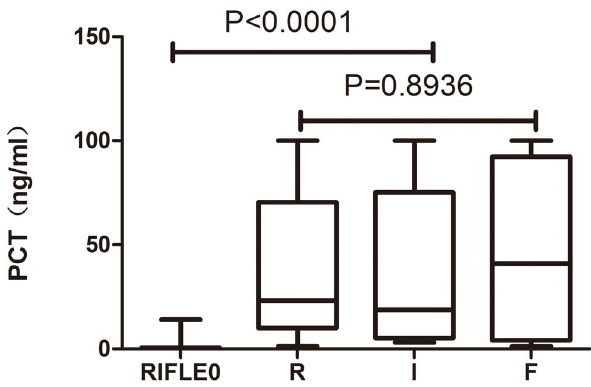
Figure 4. PCT levels in patients stratified by RIFLE classes. RIFLE=Risk, Injury, Failure, Loss, and End-stage kidney disease. PCT levels were compared between AKI (RIFLE classes Risk, Injury, and Failure) and non-AKI (RIFLE 0) patients using the Wilcoxon rank sum test, and PCT levels were compared among the RIFLE classes Risk, Injury, and Failure using the Kruskal-Wallis H test.